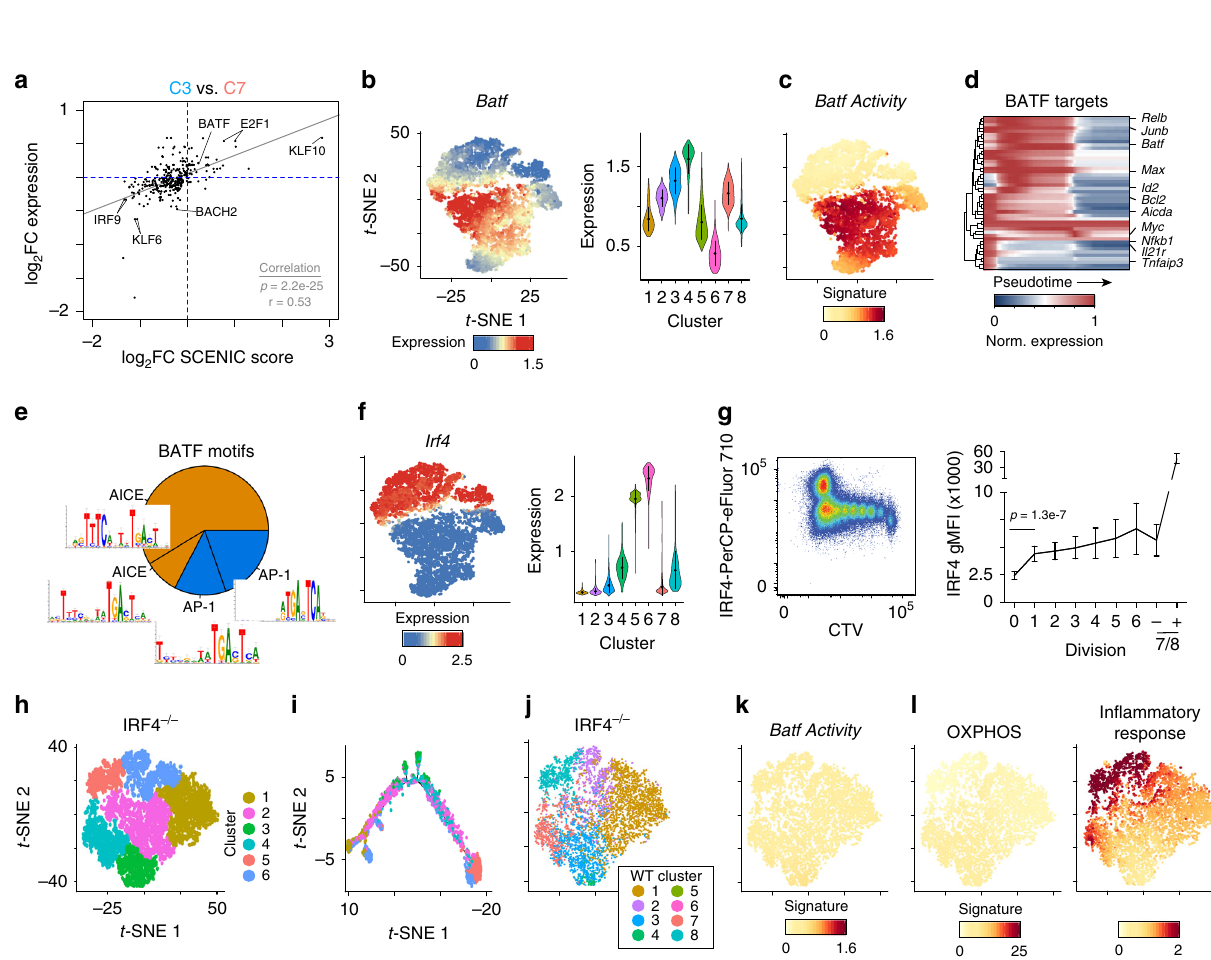
Fig. 6 IRF4 is critical for establishing the ASC-destined branch transcriptional program. a Scatter plot showing the expression log 2 fold change (log 2 FC) versus the log 2 FC in SCENIC activity score between cluster 3 versus 7 for each transcription factor. Gray line represents linear regression with signi fi cance determined by one-way ANOVA. Pearson ’ s r correlation is indicated. b t -SNE plot (left) from Fig. 4a and violin plot (right) showing the MAGIC gene expression data for the indicated gene. For violin plots, dots represent mean and lines represent fi rst and third quartile ranges. c t -SNE plot showing mean MAGIC expression levels for BATF target genes determined by SCENIC. d Heatmap showing expression of 46 BATF target genes along pseudotime in WT cells. For each gene, the mean MAGIC expression level is normalized to the maximal value. e Pie chart representing the percentage of BATF target genes containing either the canonical AP-1 or composite IRF:AP-1 (AICE) motif. f t -SNE plot (left) and violin plot (right) showing the MAGIC gene expression data for the indicated gene. For violin plots, the dots represent mean and lines represent fi rst and third quartile ranges. g Representative fl ow cytometry (left) and geometric mean fl uorescence intensity at each cell division (right) for intracellular staining of IRF4 levels versus CTV in LPS- responding B cells 72 h after LPS inoculation. Division 7/8 cells are subdivided into CD138 negative ( − ) and positive ( + ). Data represent mean ± SD and statistical signi fi cance determined by two-tailed Student ’ s t test. Data represent two independent experiments of nine mice. h t -SNE plot of 6903 Cd19 Cre/ + Irf4 fl / fl (IRF4 – / – ) cells responding to LPS showing the location of six distinct cell clusters. Data represent combined cells from two independent mice. i t -SNE plot of pseudotime ordered cells from ( h ) showing the location of cells from each cluster. j t -SNE plot from ( h ) showing the annotation of each cell with a WT cluster from Fig. 4a. k t -SNE plot from ( h ) showing mean MAGIC expression levels for BATF target genes as in ( c ). l t -SNE plot from ( h ) showing mean MAGIC expression for Leading Edge genes from the indicated gene set (see Fig. 5e). Source data are provided as a Source Data fi